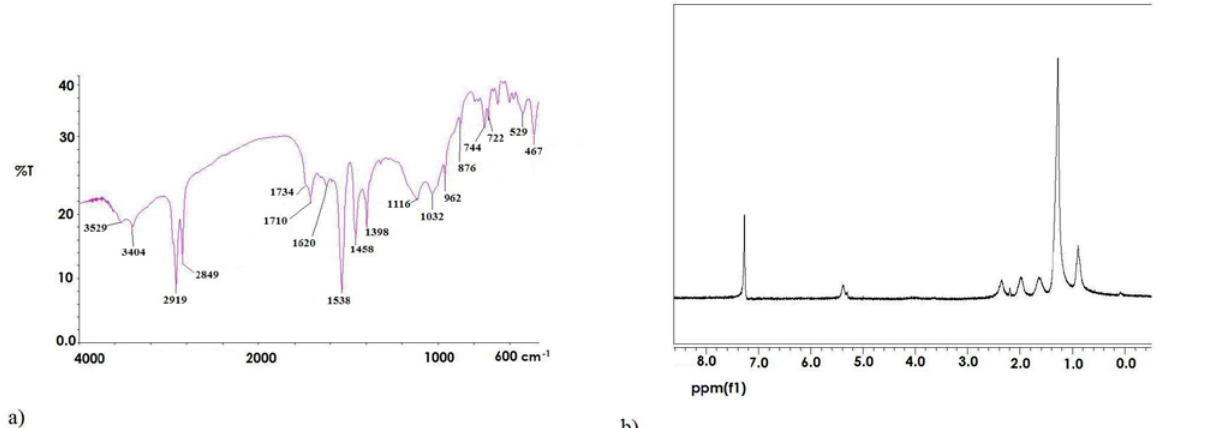
Figure 5. Product E, sample 7 - a) FT-IR spectrum; b) Soluble fraction in CDCl 3 , 1 H-NMR (CDCl 3 )